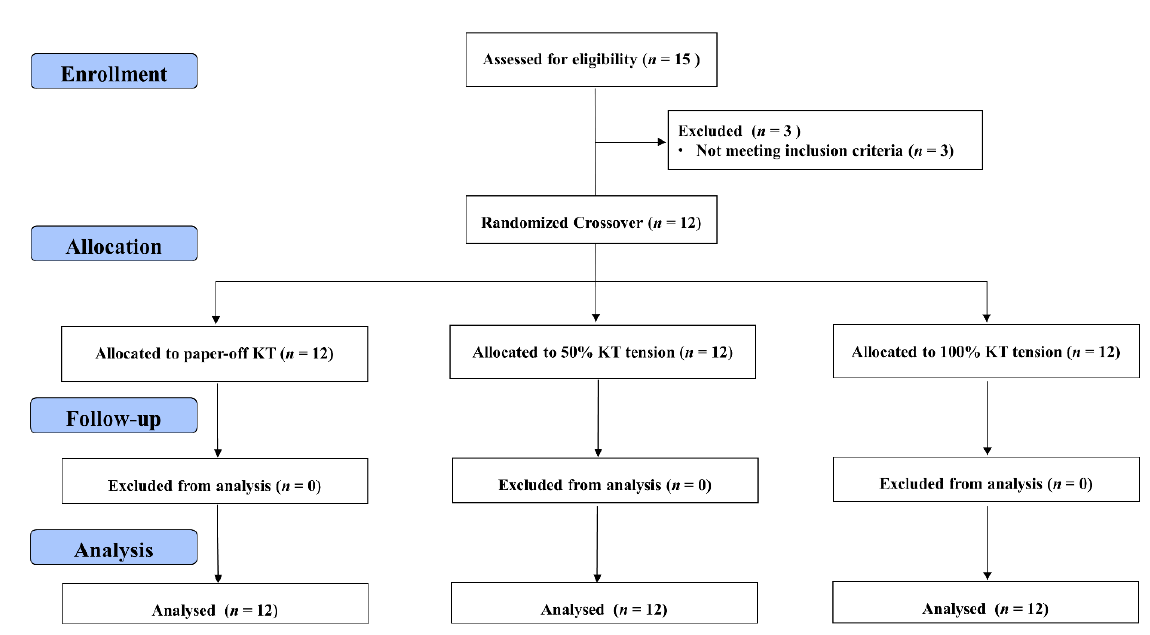
Figure 1. Experimental flow diagram of the